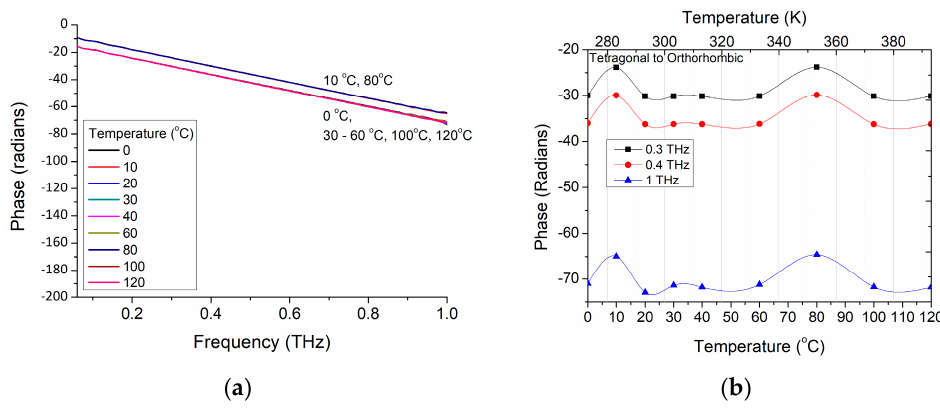
Figure 3. Phase changes in BaTiO3 nanoparticles ( a ) with frequency at different temperatures and ( b ) with temperature at three frequencies of 300 GHz, 400 GHz, and 1 THz.